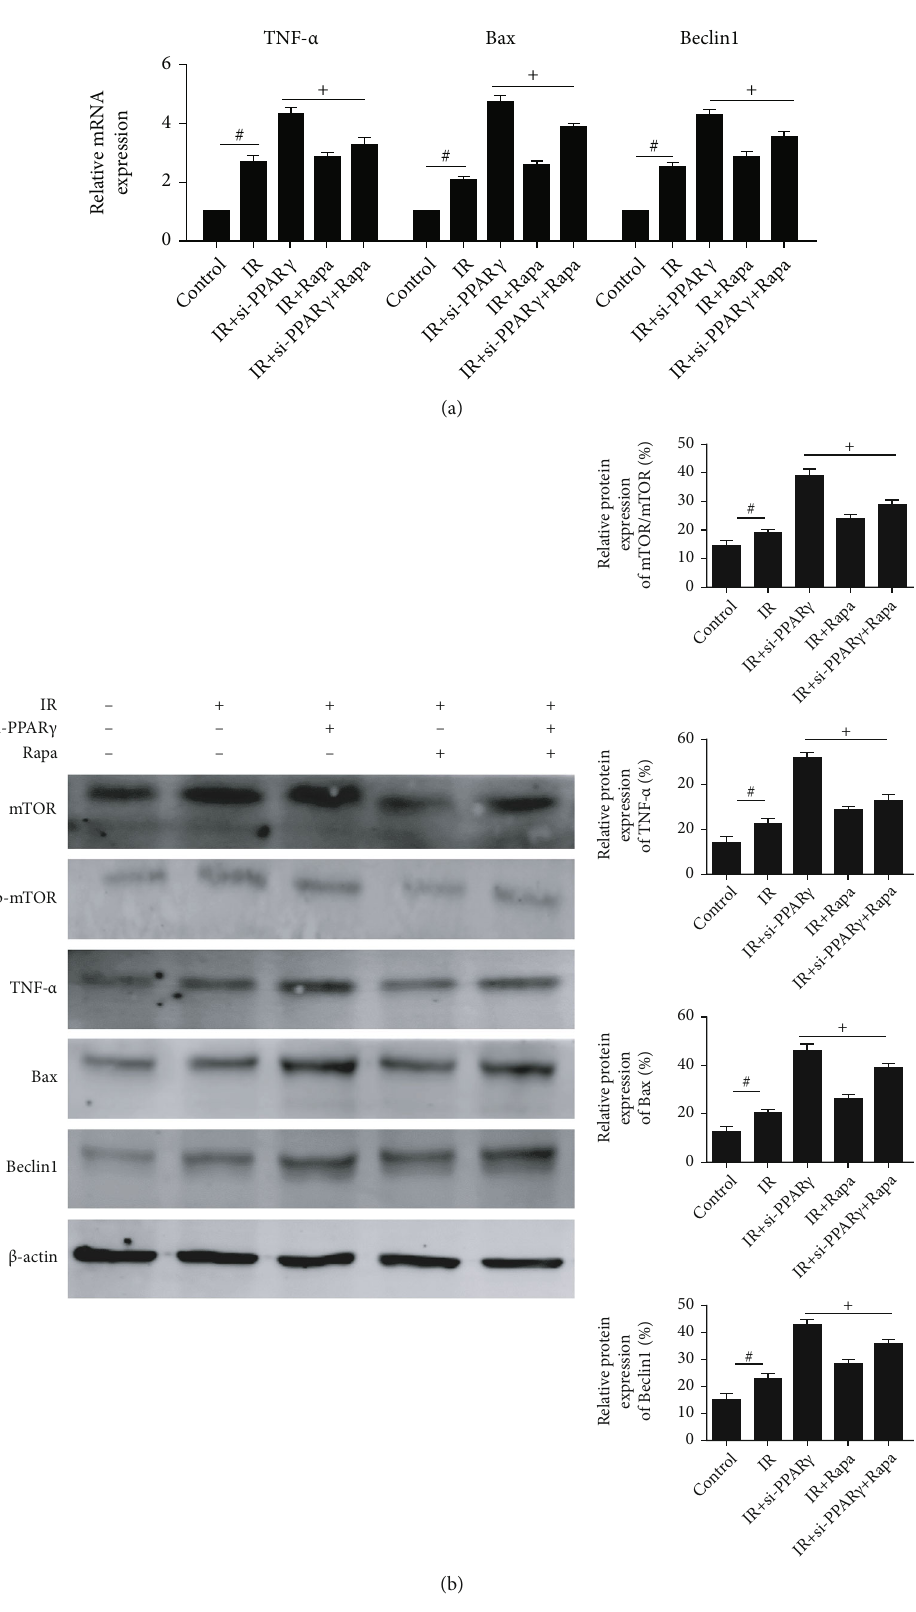
Figure 5: The involvement of AMPK/mTOR in the e ff ects of PPAR γ in IR. Notes: (a) relative mRNA expression of TNF- α , Bax, and Beclin1 ( n = 3 , # means p < 0 : 05 for IR versus control, + means p < 0 : 05 for IR ± si-PPAR γ ± Rapa versus IR); (b) protein expression of mTOR, p-mTOR, TNF- α , Bax, and Beclin1 ( n = 5 , # means p < 0 : 05 for si-PPAR γ versus IR, + means p < 0 : 05 for si-PPAR γ +Rosi versus si-PPAR γ